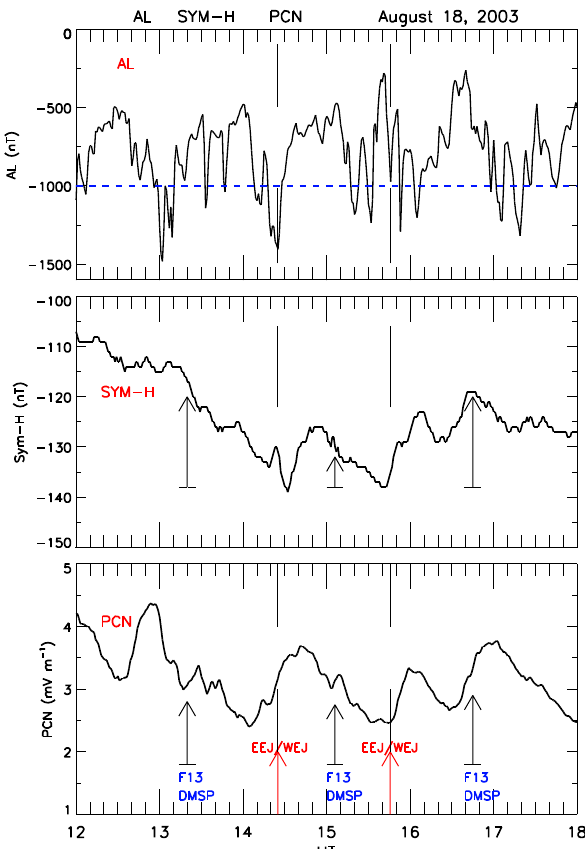
Fig. 4. AL–SYM-H–PCN indices for the interval 12:00–18:00UT. Three passes of spacecraft DMSP F13 across the oval at dusk (13:26, 15:09, 16:46UT) are marked by arrows. Two major EEJ/WEJ events at dusk (14:20 and 15:45UT) are marked by verti- cal dashed